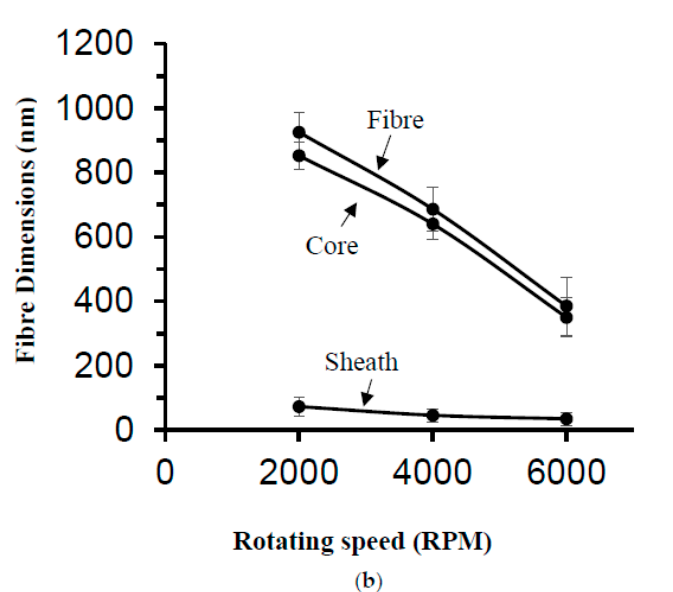
Figure 6. Fibre D2, core D1 and sheath (D2-D1) / 2 dimensions as a function of ( a ) working pressure at a constant rotating speed of 6000 RPM ( b ); a rotating speed at a constant working pressure of 0.1 MPa.